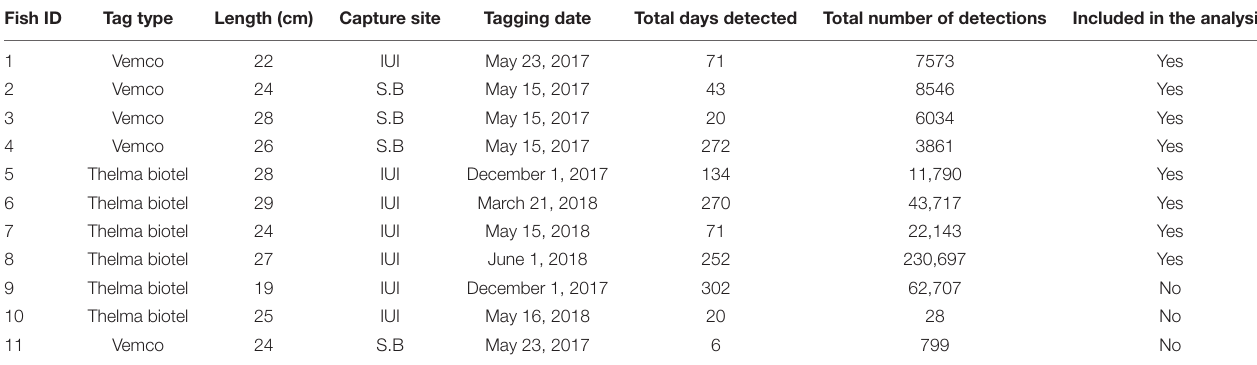
TABLE 1 | Summary information for the 11 P. miles tagged at Gulf of Aqaba during